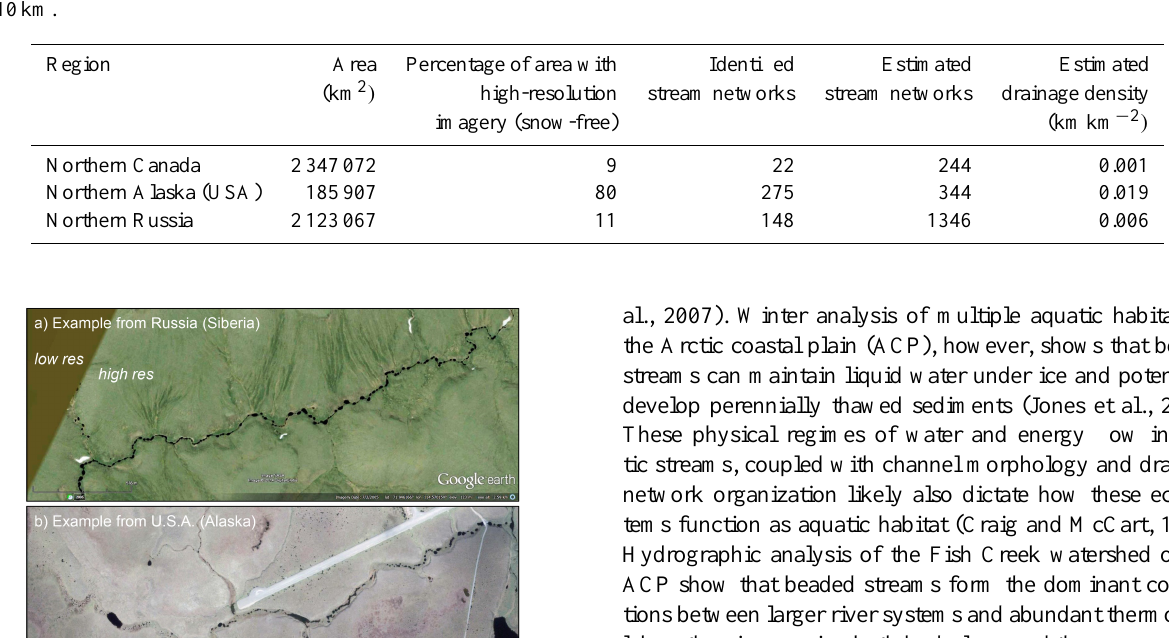
Table 1. Summary of a circum-Arctic inventory of beaded stream networks in the zone of continuous permafrost based on a survey of high-resolution (<5m, summer) imagery available in Google Earth ™ during 2012–2013. The relative proportion of high-resolution imagery available in each region was used to estimate the total number of stream networks and drainage density assuming an average network length of 10km.